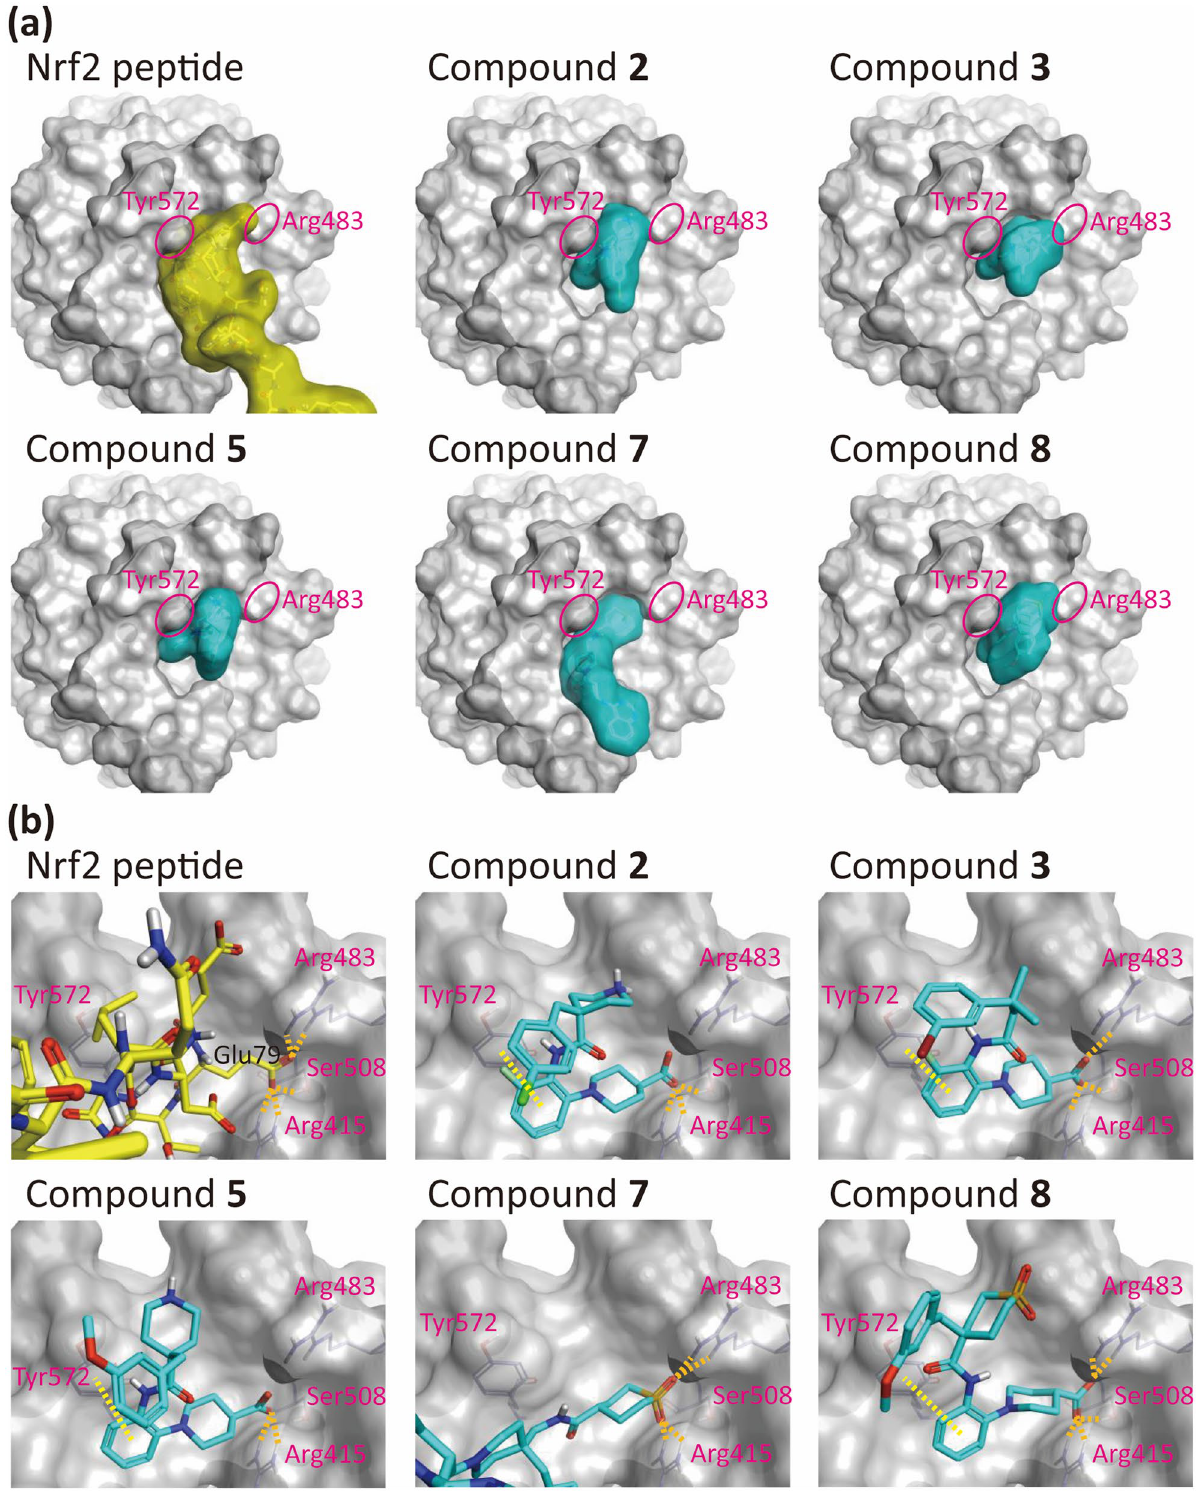
Figure 5. A binding pose of Nrf2 peptide to Keap1 protein (PDB ID: 2flu) 45 and predicted binding poses of five hit compounds ( 2 , 3 , 5 , 7 , and 8 ) to Keap1 based on 3D alignment. ( a ) The compounds fitted the binding pocket of Keap1. ( b ) Acceptor interaction (orange dashed lines) between carboxy terminus of the five compounds and Keap1 (Arg415, Arg483, and Ser508), and π-stacking interaction (yellow dashed lines) between compound ( 2 , 3 , 5 , and 8 ) and Keap1 (Tyr572) were